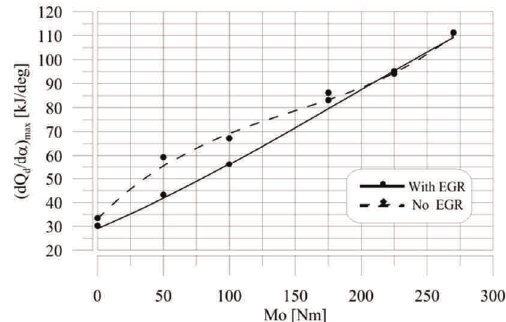
Fig. 17. Influence of the engine load on max rate of diffusion heat release (dQ d /d a ) max for engine operating with/without